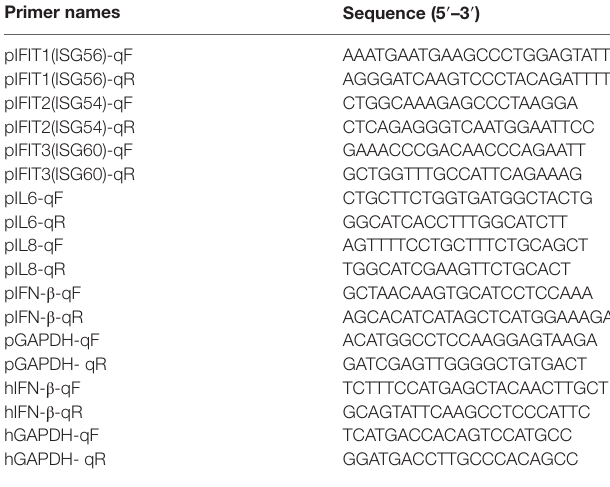
TaBle 2 | Primers used for real-time